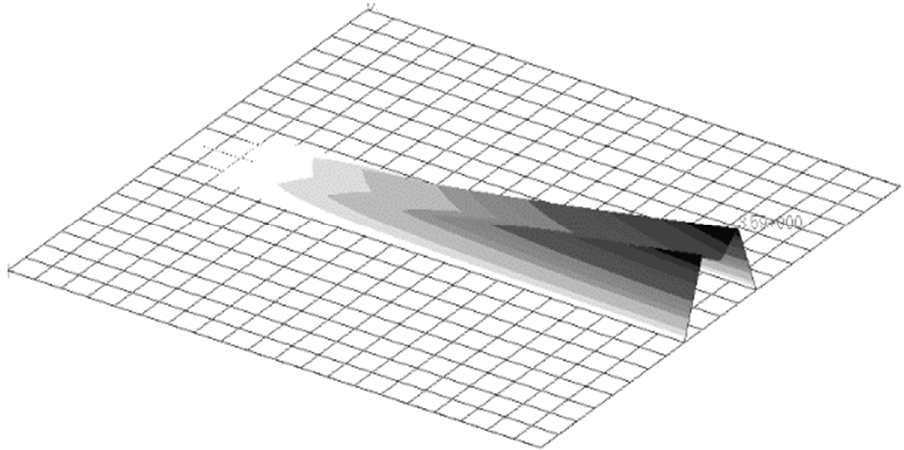
Figure 8. Local mode of the optimized model (local frequency = 60.77).